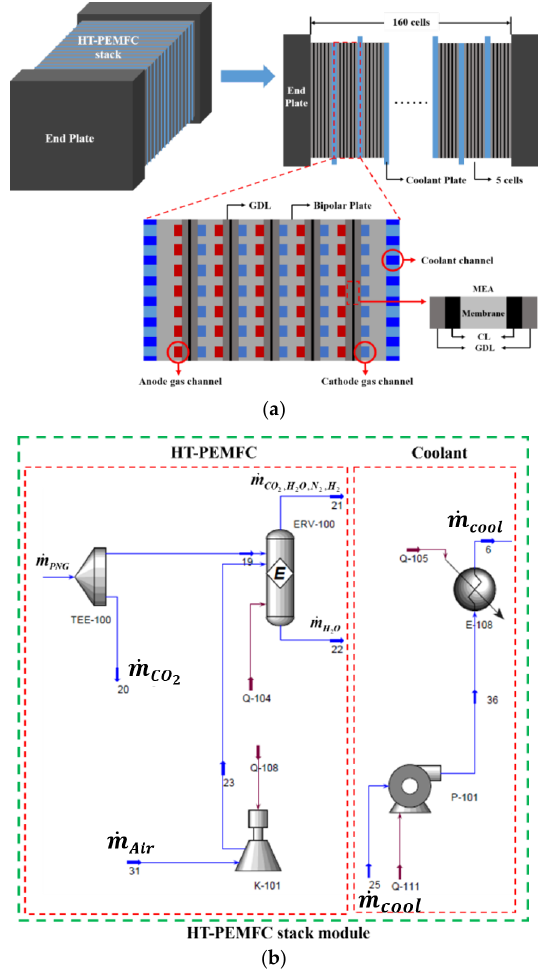
Figure 3. ( a ) Configuration of a gas/coolant channels and membrane electrode assembly (MEA) in a HT-PEMFC stack and ( b ) related flowsheet created by Aspen HYSYS ® .